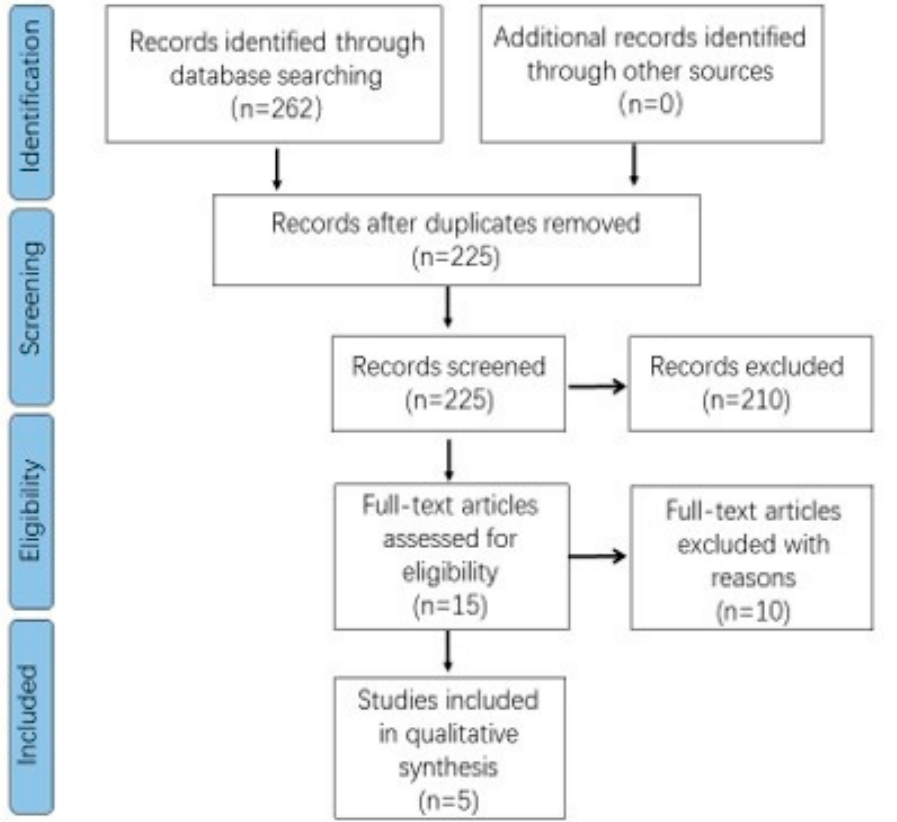
Figure 1. PRISMA flowchart showing the design of the